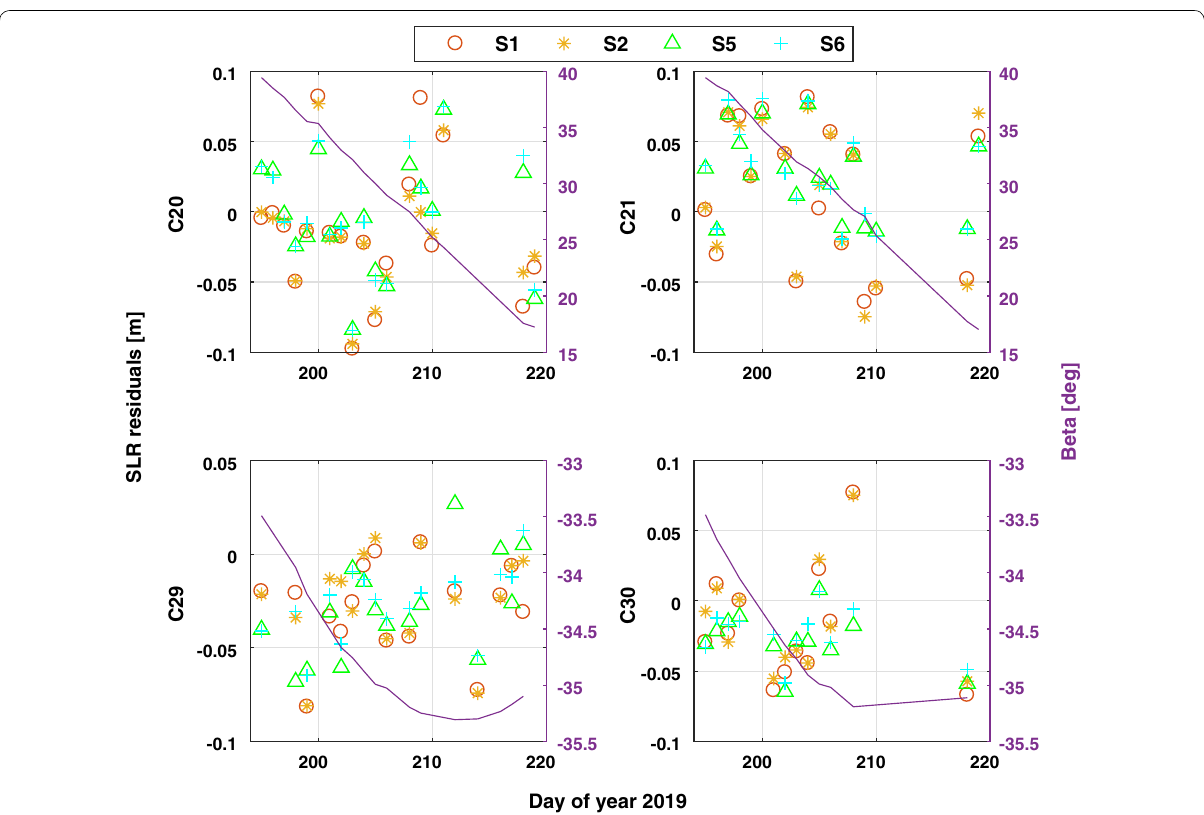
Fig. 13 SLR residual results for four BDS-3